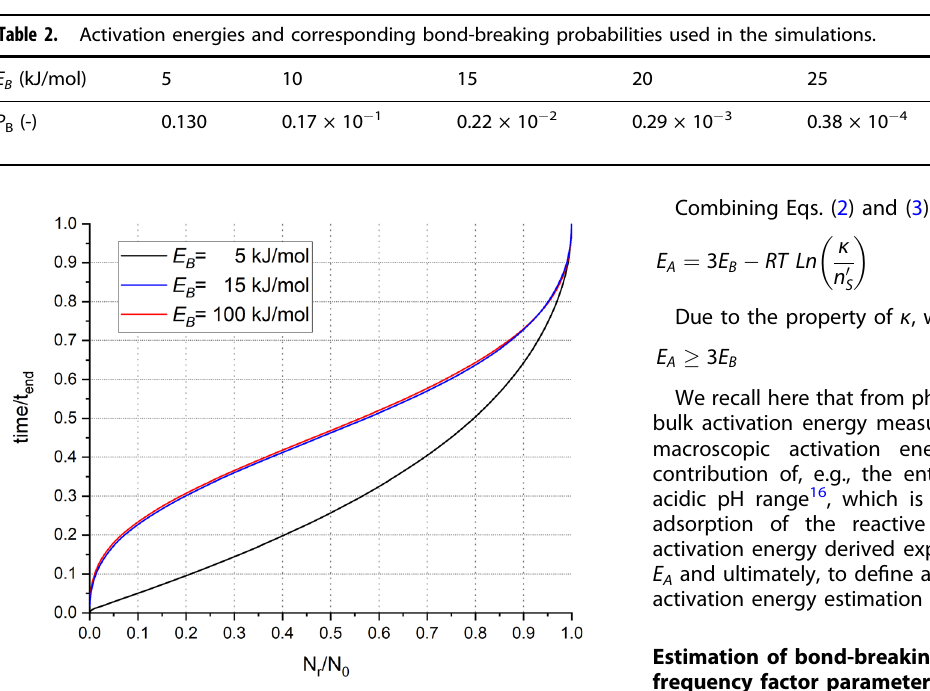
Fig. 1 Time evolution as a function of the dissolution progress. N r is the cumulated number of dissolved sites, N 0 the initial number of sites and t end , the simulated time necessary to dissolve the entire